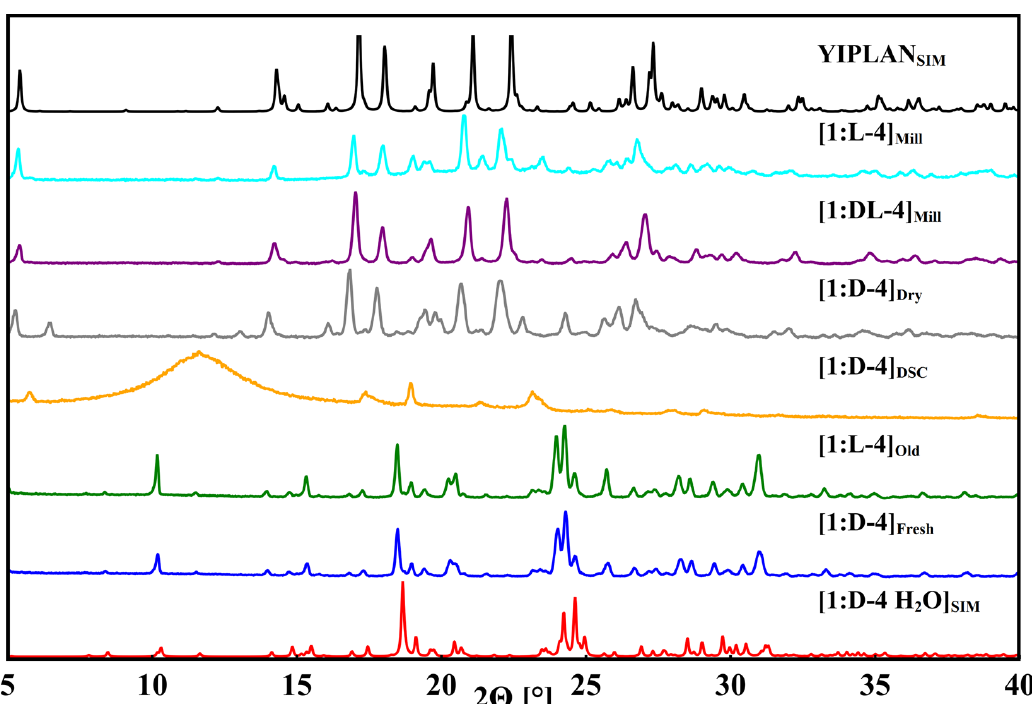
Figure 6. PXRDs of different Baclofen:malic acid systems obtained as pure phases at least once: freshly synthesized sample of 1:D − 4 • H 2 O (blue) and a six months old sample of 1 : L − 4 • H 2 O (green), both obtained from hexafluoro-2-propanol solution contaminated with water; 1 : D − 4 • H 2 O sample after heating to 140 °C (orange) or vacuum drying (grey); samples of 1 : DL-4 • H 2 O (purple) and 1 : L − 4 • H 2 O (cyan) after methanol-assisted grinding. Simulated patterns of obtained 1 : D − 4 • H 2 O (red) and previously reported by Córdova-Villanueva et al. [50] (Crystal Structure Database, Ref. Code YIPLAN) (black) are shown for comparison.